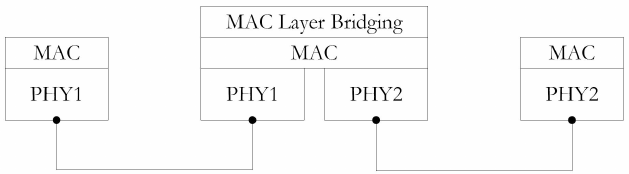
Figure 2. Bridging procedure: Protocol